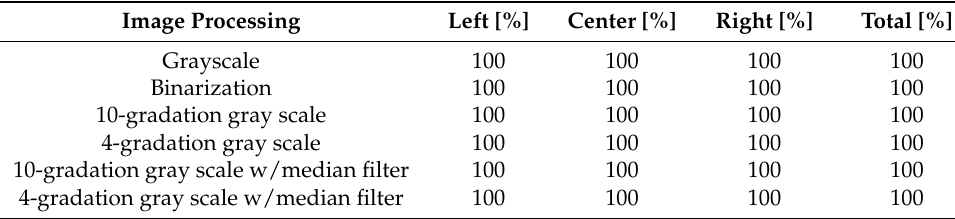
Table 10. Experimental results in real space with the proposed scheme.